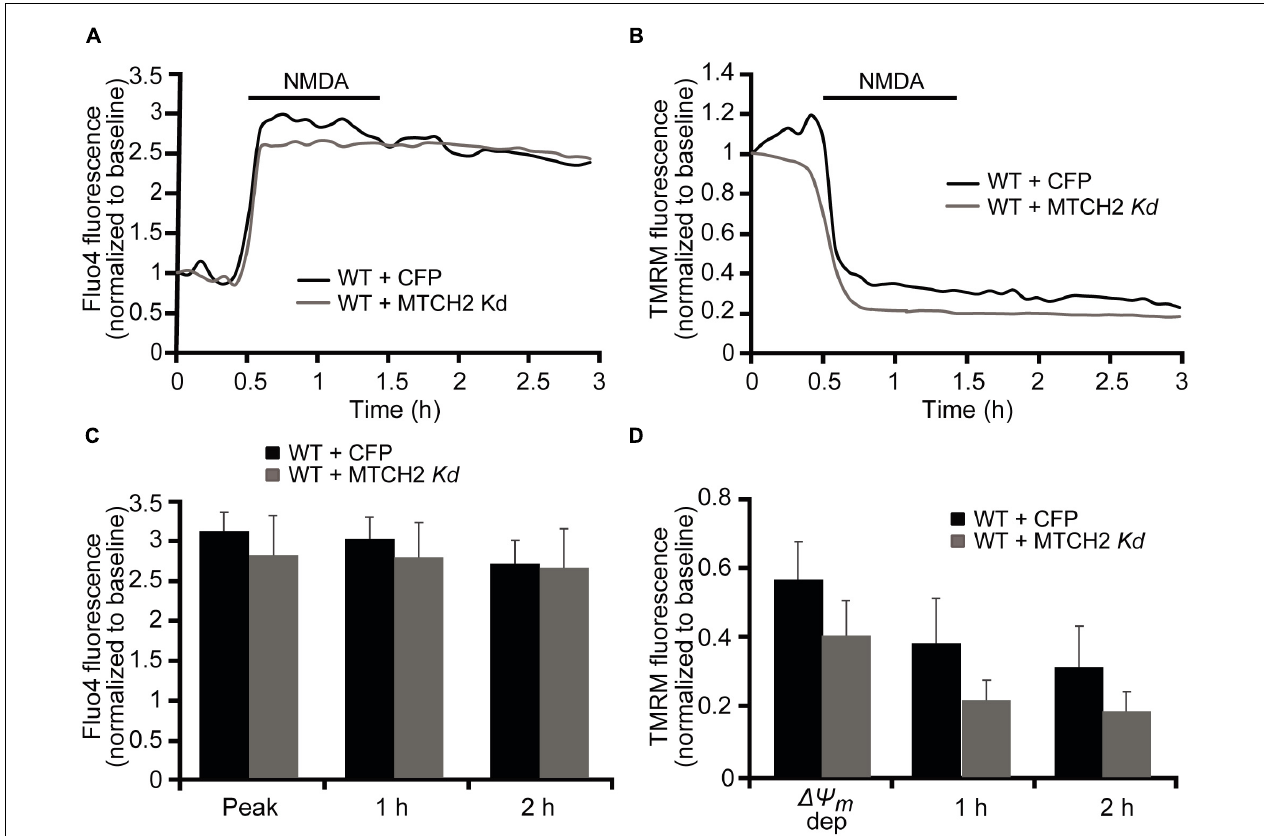
FIGURE 3 | Mtch2 gene silencing does not diminish NMDA-induced Ca 2 + in WT cortical neurons. WT cortical neurons, transfected with an shRNA plasmid against Mtch2 or a control empty vector (ECFP) for 36 h and co-loaded with TMRM (20 nM) and Fluo-4 AM (3 µ M), were exposed to NMDA (300 µ M/60 min NMDA) and monitored by confocal microscopy (LSM 710). (A,B) Representative Fluo4-AM (A) and TMRM (B) traces measuring alterations in intracellular Ca 2 + influx and (cid:49) ψ m , respectively, at point of stimulation (300 µ M/60 min NMDA) and following the initial excitotoxic stimulus. (C) Analysis of the relationship Fluo-4 fluorescence at the indicated time points compared to peak Fluo-4 AM fluorescence at NMDA exposure. WT cortical neurons transfected with Mtch-2 kd plasmid: n = 18 neurons from n = 5 separate cultures. Empty vector: n = 25 neurons from n = 5 separate cultures. Data are shown as means ± SEM ( p ≥ 0.05; ANOVA, post hoc Tukey’s test). (D) Average of TMRM fluorescence in WT cortical neurons transfected with Mtch-2 kd plasmid ( n = 18; from n = 5 separate cultures) or control vector ( n = 25; from n = 5 separate cultures) during and after NMDA excitation. Means ± SEM are shown ( p ≥ 0.05; ANOVA, post hoc Tukey’s